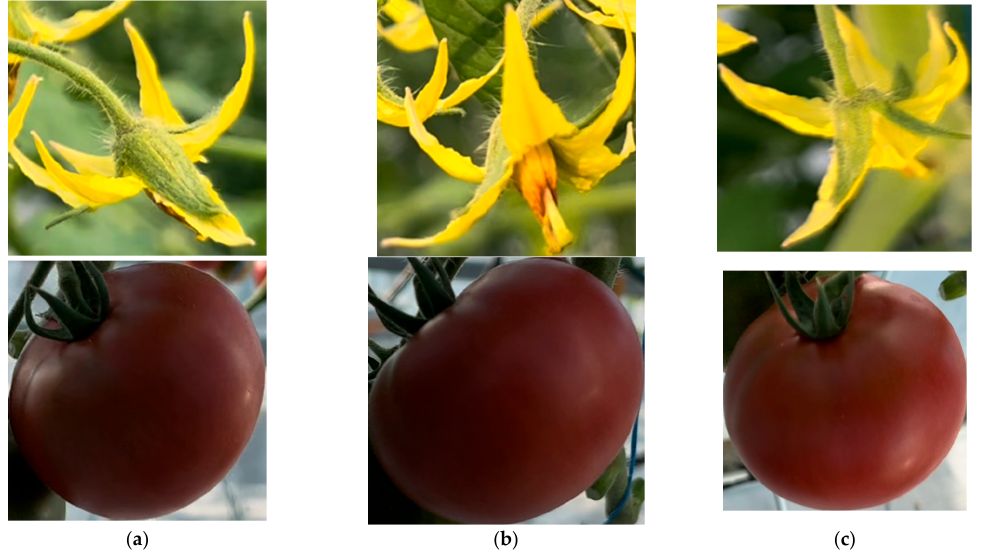
Figure 5. Targets were shot from three different camera angles. ( a ) Shooting angle a; ( b ) Shooting angle b; ( c ) Shooting angle